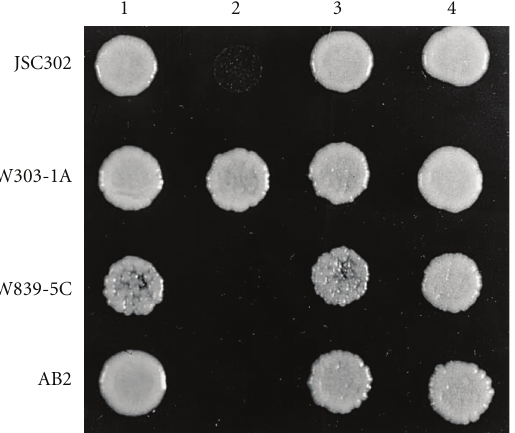
Figure 4: Drop test experiment: 3 μ L droplets of plasmid- containing standard yeast suspensions containing about 20 000 ura+colony-forming units were deposited on the appropriate selective media to allow expression of the HIV-1 integrase in yeast. When the drops had dried, plates were incubated for 3 days, and the e ff ect of integrase expression on yeast was determined by visual observation of the Petri dishes. Lethality is observed when IN is expressed in yeast (2) but not in the presence of empty plasmid (1) or when expressing inactive D116A or E152A IN (3 and 4). JSC302 and W303-1A: RAD52+, W839-5C: identical to W303-1A except for RAD52 gene disruption. AB2: diploid obtained from W303-1A (adapted from